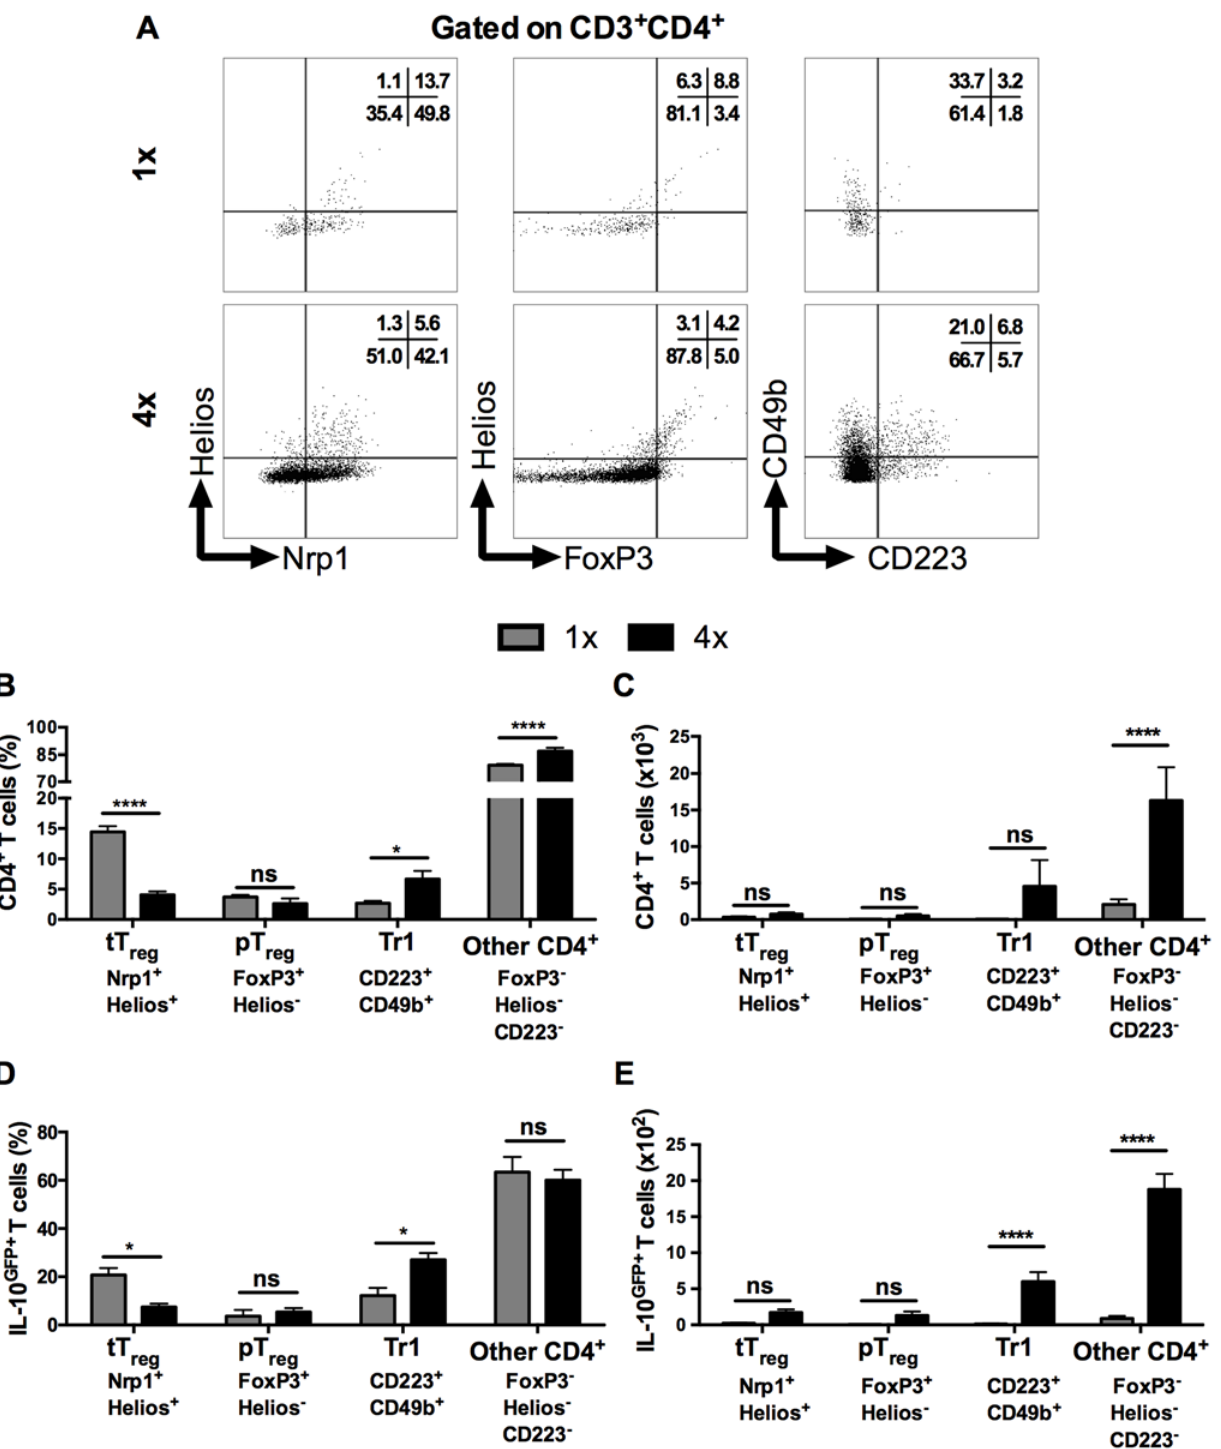
Fig 3. IL-10 producing dermal CD4 + cells do not express markers of conventional regulatory T cells. ( A ) Representative flow cytometry dot plots for thymic (Nrp1 + Helios + ) T reg cells, peripheral (FoxP3 + Helios - ) T reg cells, and Tr1 (CD223 + CD49b + ) cells. ( B ) Mean proportion +SEM and ( C ) absolute numbers of dermal CD4 + thymic and peripheral T reg cells, as well as Tr1, and other CD3 + CD4 + (Helios - FoxP3 - , not co-expressing CD223 plus CD49b) dermal cell populations recovered from 1x (grey), or 4x (black) infected mice on day 4 post-final exposure. ( D ) Mean proportions +SEM and ( E ) absolute numbers of dermal T cells defined in A gated on IL-10 GFP+ CD4 + T cells from 1x or 4x infected mice. ANOVA and Sidak ’ s multiple comparisons test were performed to compare the means of selected groups ( * = p < 0.05; **** = p < 0.0001; ns = p > 0.05). doi:10.1371/journal.ppat.1004841.g003 PLOS Pathogens | DOI:10.1371/journal.ppat.1004841 May 14,